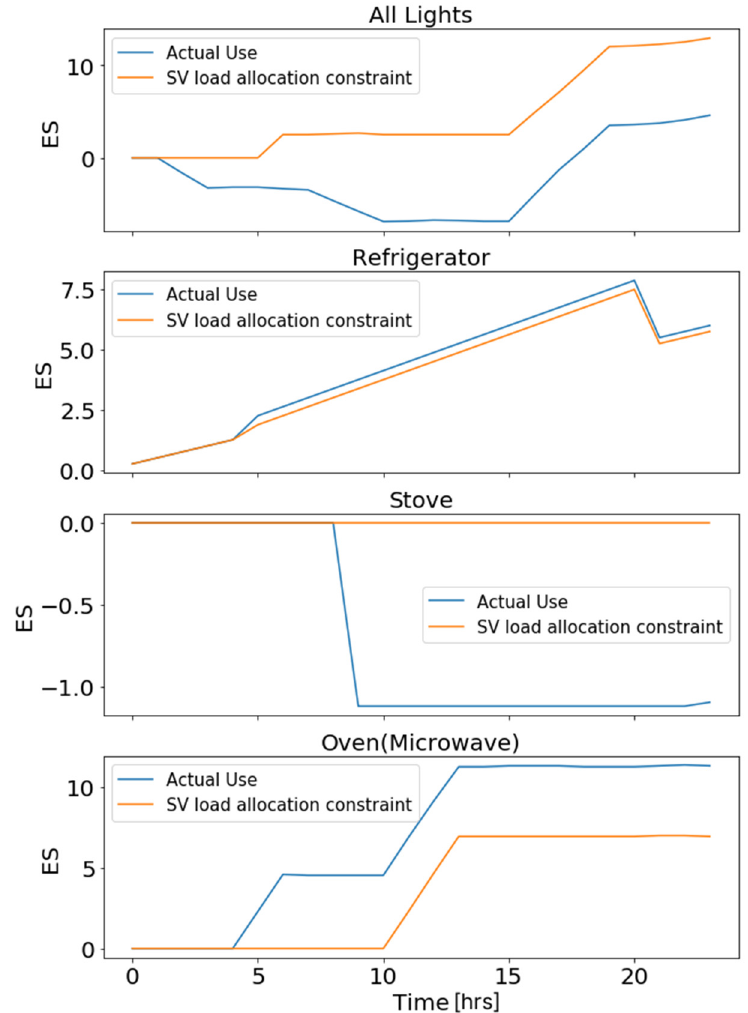
Figure 6. ES derived from each device with the proposed SV load allocation algorithm vs. real usage according to the REDD [31] database.